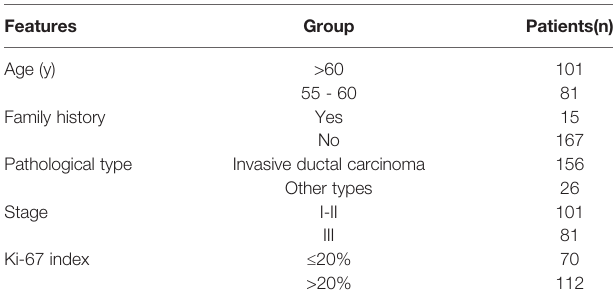
TABLE 1 | Basic clinical characteristic of postmenopausal patients enrolled in